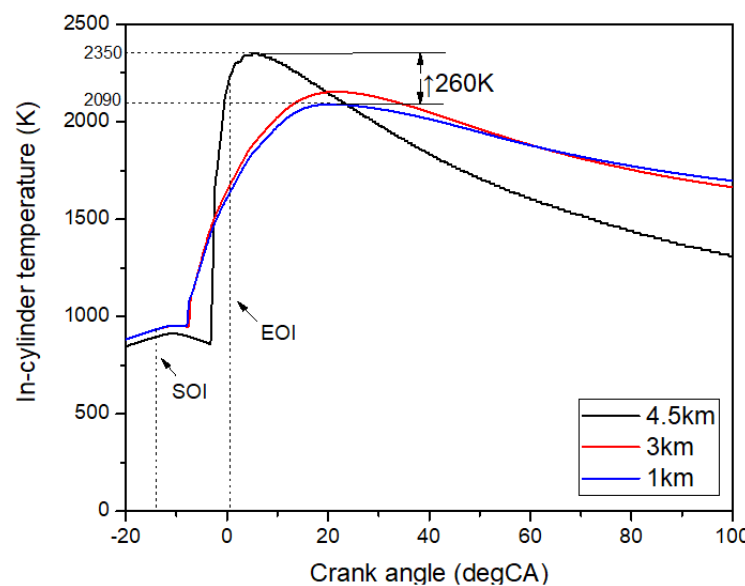
Figure 10. Comparison of mean in-cylinder temperature.